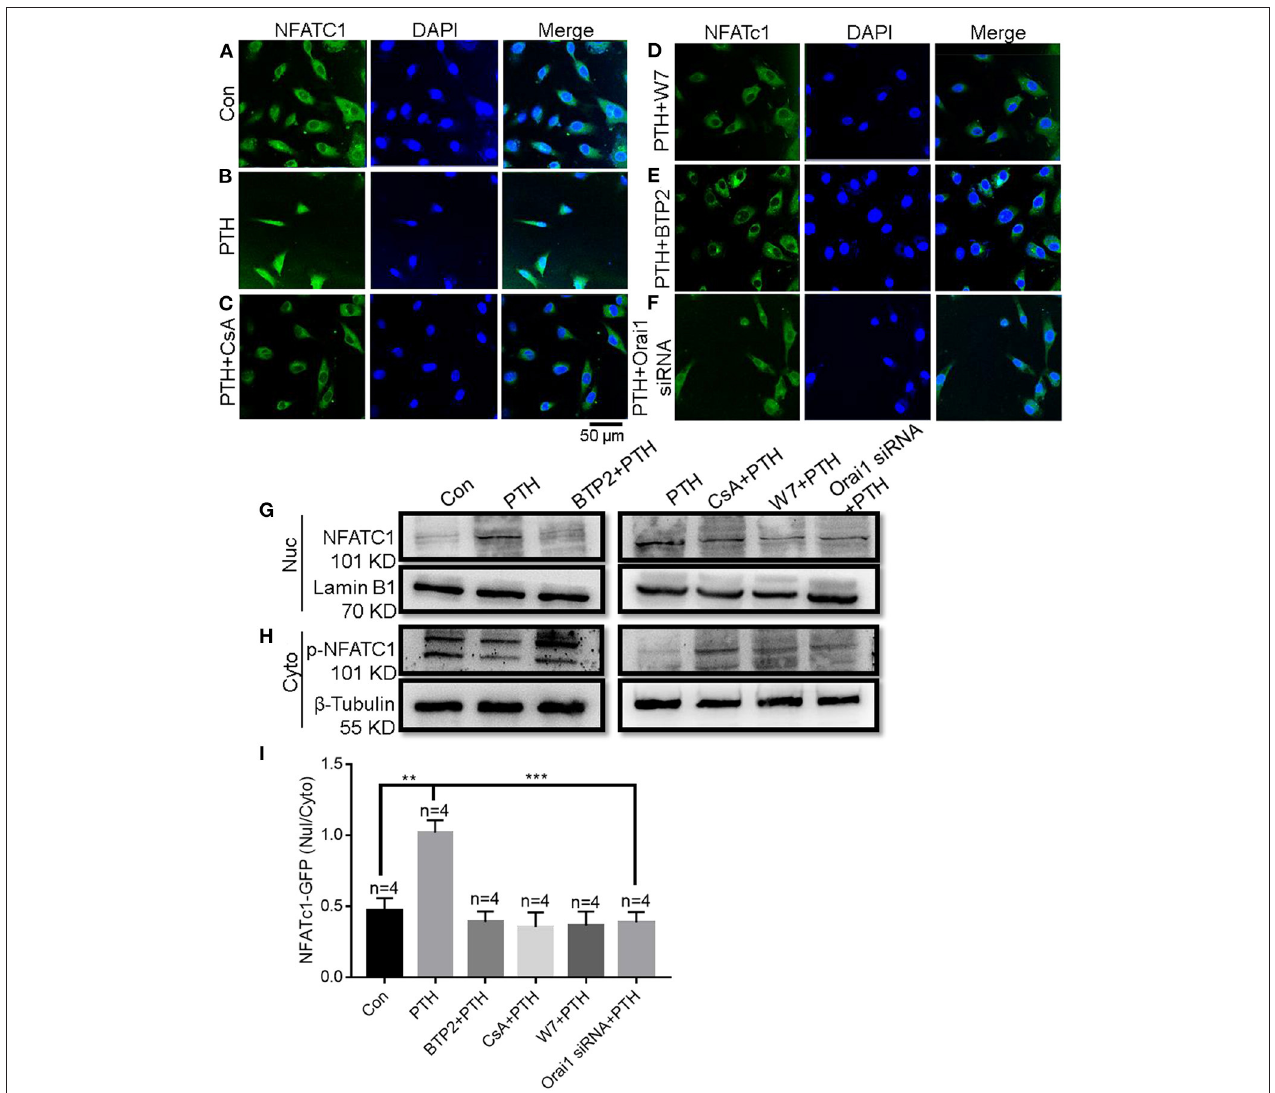
FIGURE 6 | Role of Orai1-mediated store-operated Ca 2 + entry (SOCE) in parathyroid hormone (PTH)-induced NFAT nuclear translocation in human umbilical vein endothelial cells (HUVECs). (A–F) Representative confocal microscopy images and summary data (I) showing NFATC1 distribution in HUVECs treated for 24h with (A) vehicle control, (B) 100 pM PTH, (C) PTH + CsA (calcineurin inhibitor), (D) PTH + W7 (calmodulin antagonist), (E) PTH + BTP2 (an Orai nonspecific inhibitor) or (F) PTH + Orai1 siRNA transfection. Green fluorescence indicates NFATC1; Blue, 4 ′ ,6-diamidino-2-phenylindole (DAPI) indicates nuclei. Data are shown as the mean ± SEM; n = 4. ** P < 0.01, *** P < 0.001 vs. Con or PTH analyzed by one-way analysis of variance followed by Dunnett’s multiple comparisons test. (G,H) Representative Western blot images showing fractionation assay results indicating the presence of p-NFATC1 in the cytoplasmic [Cyto, (H) ] and NFATC1 in